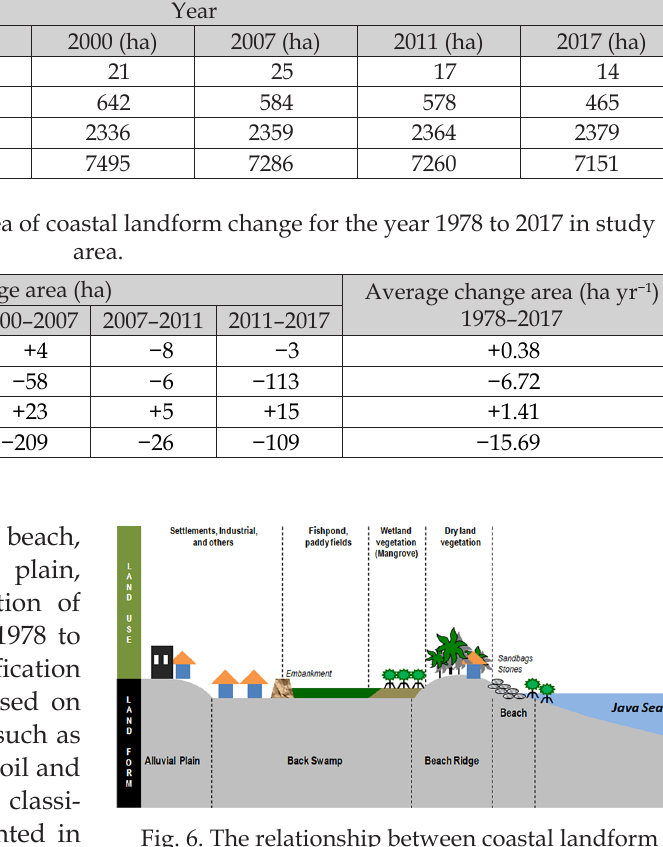
Table 2. The estimated area of coastal landform change for 1978 to 2017 in the study area. Coastal landform